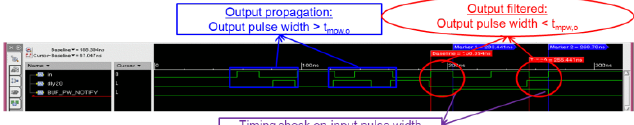
Figure 18. GLS illustration of a buffer with pulse width filtering